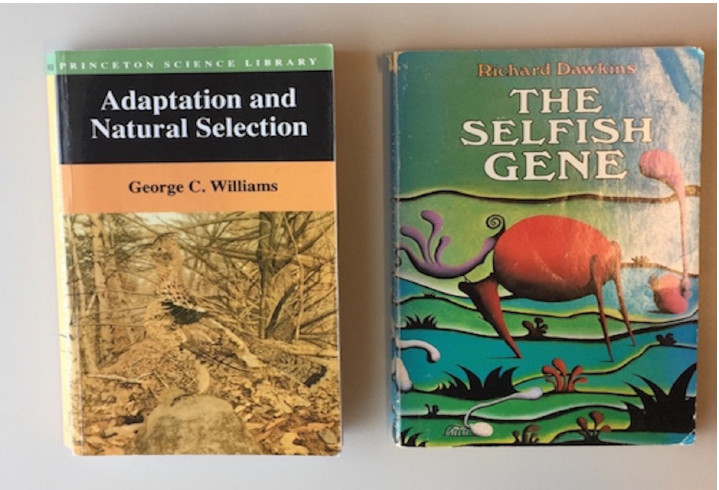
Fig 1. George Williams’ Adaptation and Natural Selection (1966) and Richard Dawkins’ The Selfish Gene (1976) were instrumental in introducing the gene’s-eye view to evolutionary biology.